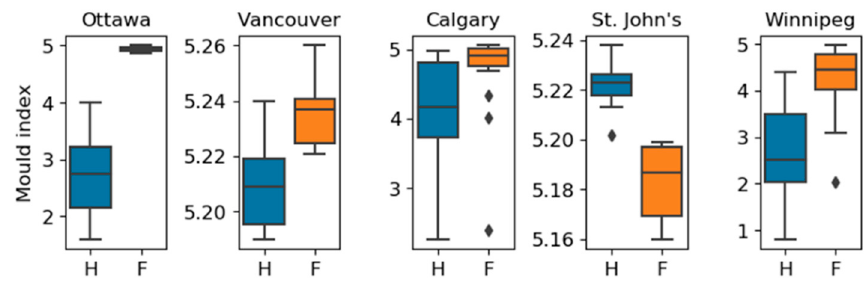
Figure 6. Boxplots of the maximum mold index obtained per run under the historical (H) and future (F) time periods in the cities of Ottawa, Vancouver, Calgary, St. John’s and Winnipeg. Table 3. Projected changes in mold index statistics under a global warming scenario of 3.5 °C (F: 1962–1992) in comparison with the reference period (H: 1986–2016).